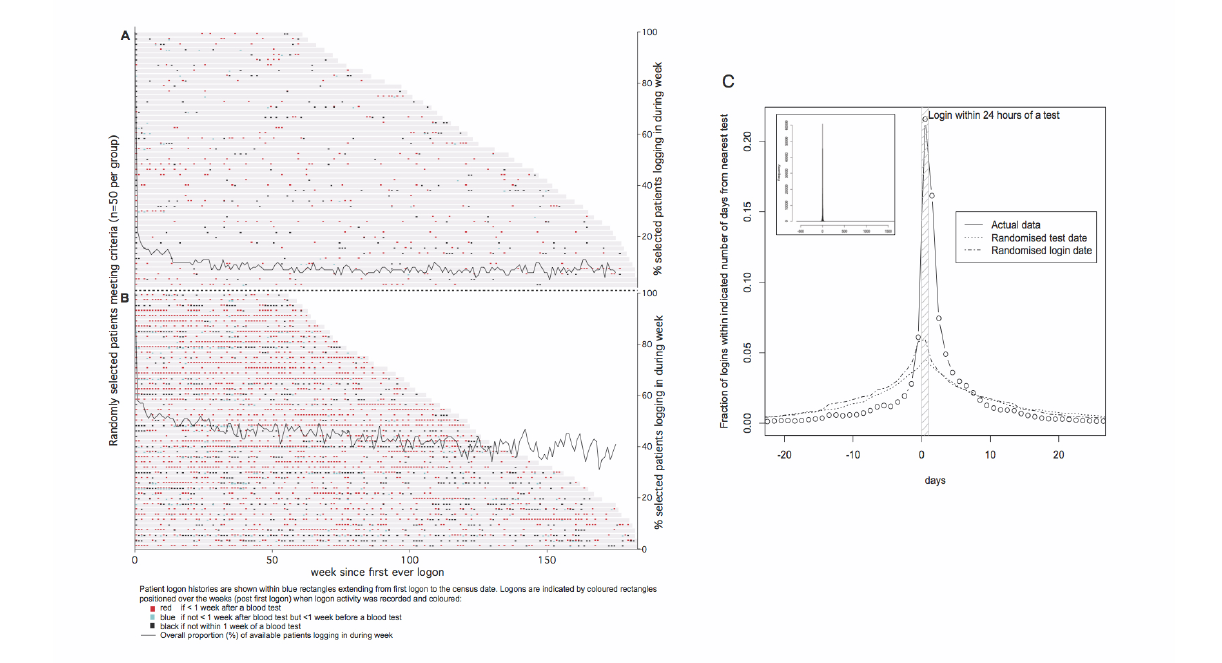
Figure 7. Relationship between times of patient logons and blood test results. A, B: Individual logon events shown by interval (in weeks) since first logon for randomly selected lower (A) and higher (B) frequency transplant recipient users where each selected patient’s activity is depicted by a horizontal series of colored dots. Most logon events are red indicating they occurred less than 1 week after a new blood result event. Superimposed is the proportion (% on the right hand axis) of patients in the respective activity groups that log in each week post first logon. C: Histogram (1 day bins) showing the predominance of logons occurring 1-3 days after tests is strikingly different from that observed with randomly shuffled